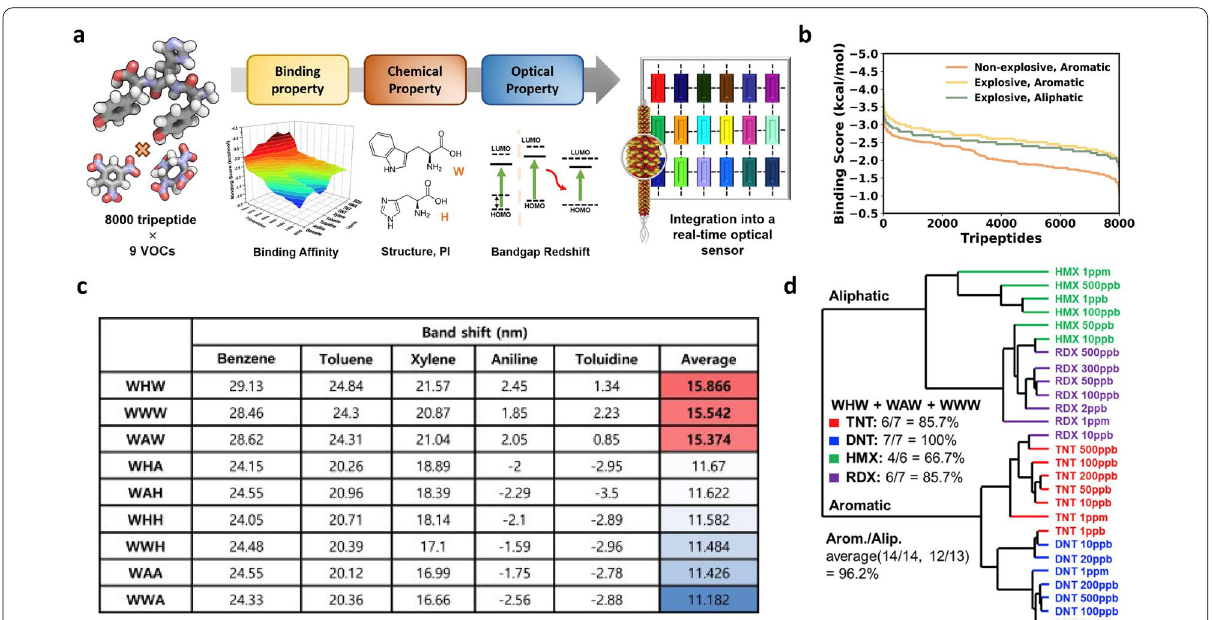
Fig. 8 Multi‑scale computational prediction and experimental validation. a The overall schematization of the screening of 8000 tripeptides versus nine VOCs. b Score distribution in the docking of 8000 tripeptide versus 3 chemical classes. c Band redshift of functional peptides with W on the N terminus calculated by first‑principles simulation. d Hierarchical cluster analysis dendrogram of aliphatic and aromatic explosives ( a – d Reproduced with permission from Ref. [55]. Copyright 2021, Elsevier